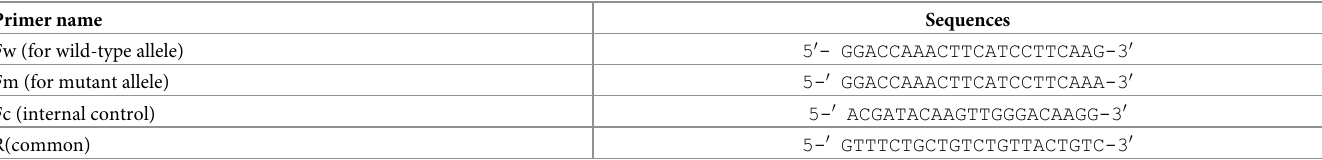
Table 1. ARMS PCR primers for TMPRSS2 rs12329760 genotyping